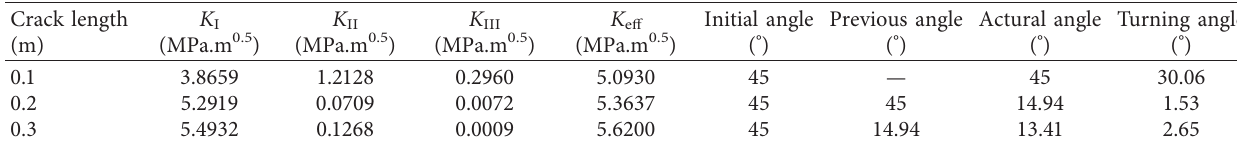
Table 2: Turning angle of the crack propagation